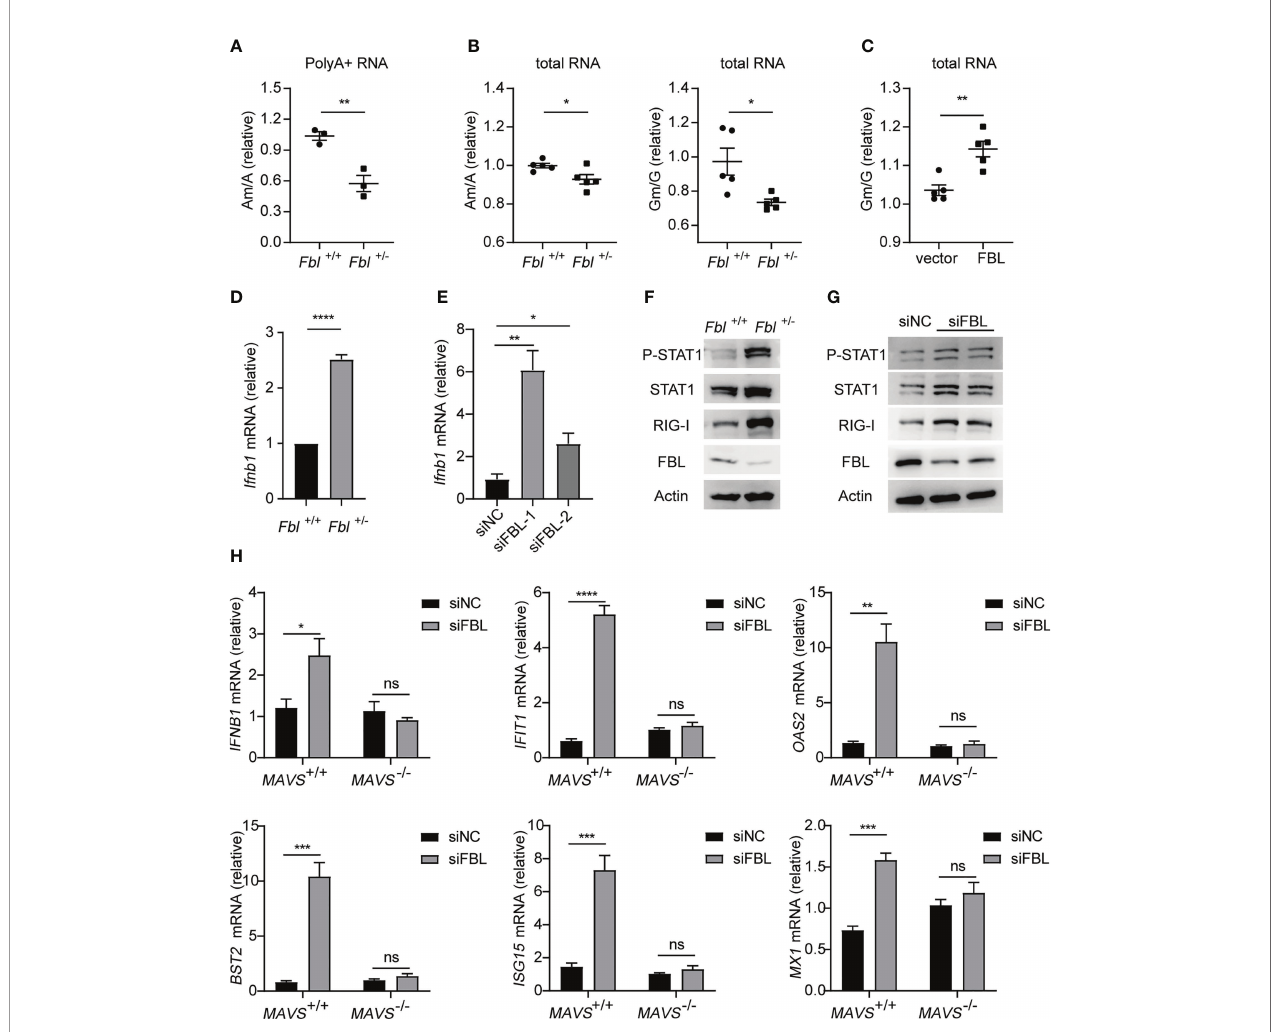
FIGURE 6 | FBL-mediated RNA 2 ’ -O methylation suppresses IFN-I expression and signaling in macrophages. (A) Quanti fi cation of the Am/A ratio in poly A+ RNA of WT and Fbl +/- RAW264.7 cells (n=3); (B) Quanti fi cation of the Am/A and Gm/G ratio in total RNA of WT and Fbl +/- RAW264.7 cells (n=5); (C) Quanti fi cation of the Am/A, Cm/C, Gm/G ratio in total RNA of Fbl +/- RAW264.7 cells transfected with empty vector and vector encoding mouse FBL for 30 h (n=5); (D) qRT-PCR analysis of Ifnb1 mRNA in WT and Fbl +/- RAW264.7 cells (n=3); (E) qRT-PCR analysis of Ifnb1 mRNA in mouse peritoneal macrophages transfected with the indicated siRNAs for 48 h (n=3); (F) Western blot of interferon signaling in WT and Fbl +/- RAW264.7 cells; (G) Western blot of interferon signaling in mouse peritoneal macrophages transfected with the indicated siRNAs for 48 h; (H) qRT-PCR analysis of IFNB1 , IFIT1 , OAS2 , BST2 , ISG15 , MX1 mRNA in MAVS +/+ and MAVS -/- A549 cells transfected with the indicated siRNAs for 48 h (n=4). All data are mean ± SEM of biologically independent samples. ns, not signi fi cant, * P <0.05, ** P <0.01, *** P < 0.001, **** P <0.0001, two-tailed unpaired Student ’ s t